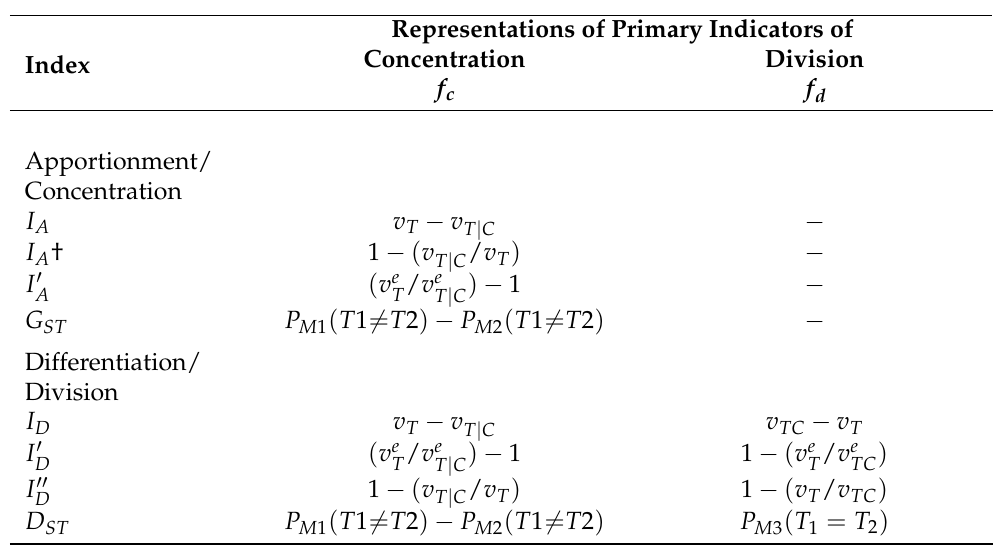
Table 3. Representations f c and f d of the primary indicators of concentration ( v T | C ) and division ( v TC ), respectively, for several indices of apportionment/concentration and differentiation/division. Recall that f c increases with increasing concentration, and f d decreases with increasing